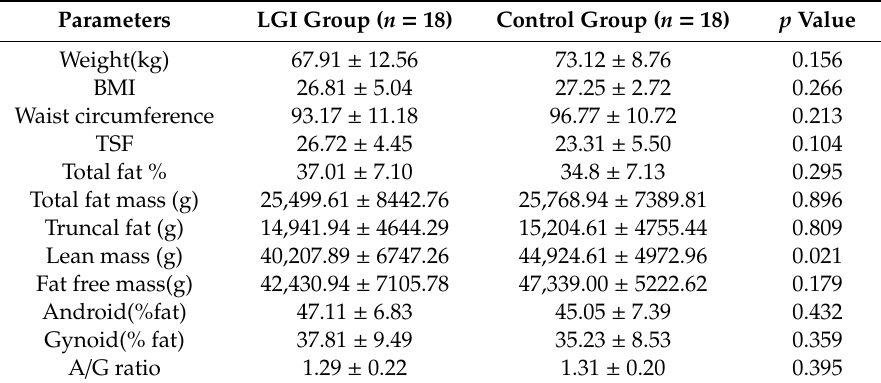
Table 2. Baseline characteristics of the study subjects.